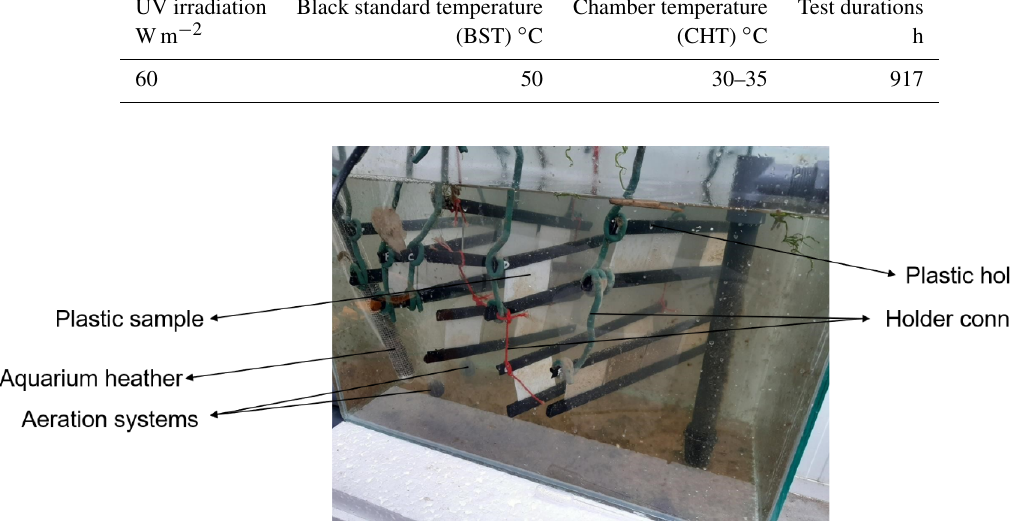
Figure 1. Aquarium setup for biofilm growth on pristine plastic specimens. The picture was taken by Giulia